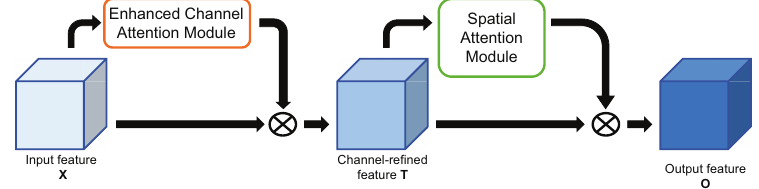
Figure 9. Diagram of spatial attention mechanism used in CBAM.